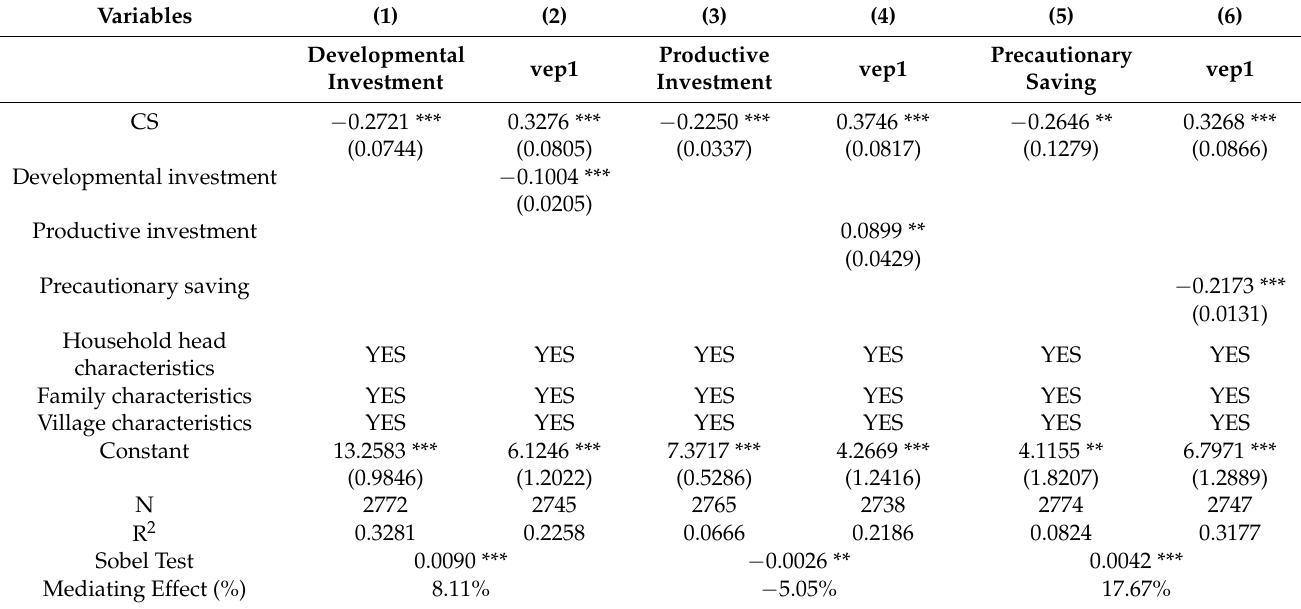
Table 6. The results of mediating effect of household resource